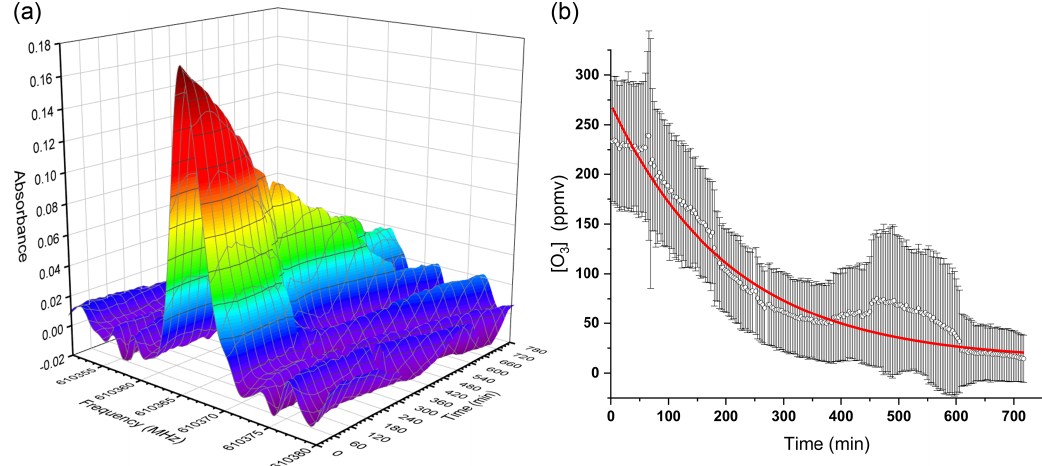
Figure 8. THz monitoring of the ozone decay in CHARME measured for 12h at P = 1.1mbar. (a) 3D plot of absorbance spectra measured every 3min of the O 3 25 1 , 25 ← 24 0 , 24 rotational transition as a function of frequency (in MHz) and time (in min). (b) First-order exponential fit of the ozone concentration decay in CHARME deduced by batch processing of the absorbances shown in (a) . A lifetime τ O is deduced from a weighted fit using the LODs as instrumental